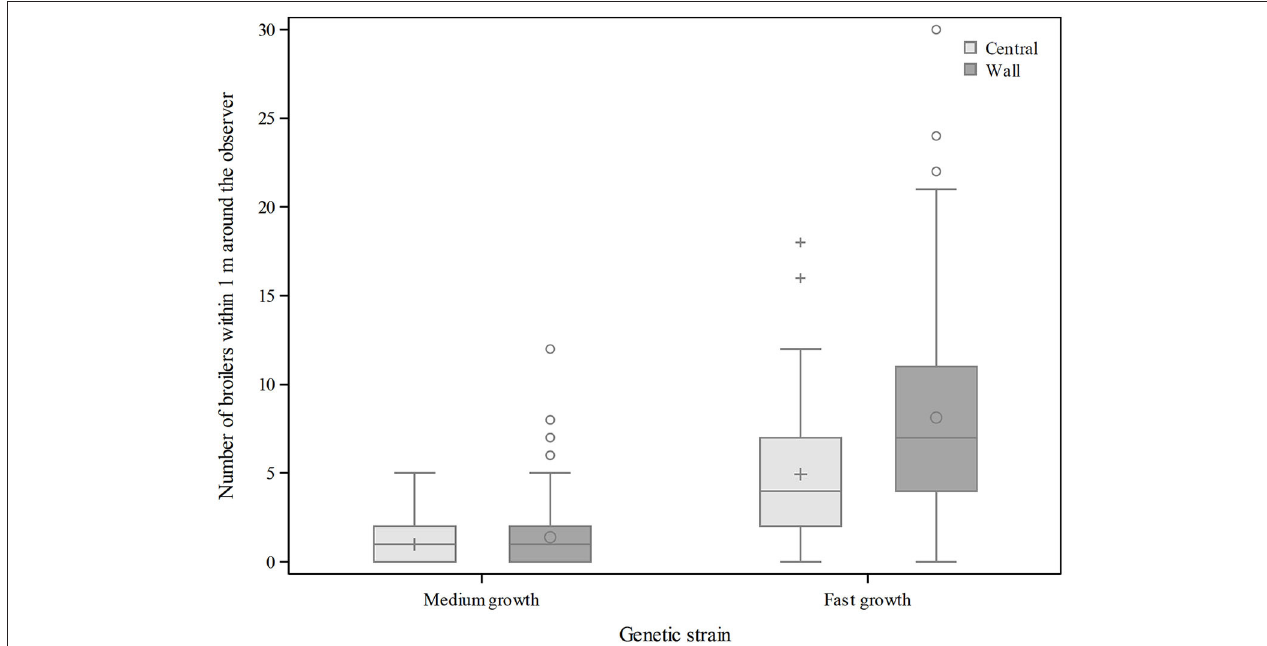
FIGURE 1 | Interaction between the genetic strain and the assessment house location on the number of broilers within 1m of the observer during avoidance tests. Boxes show interquartile ranges, and whiskers represent minimum and maximum values. Symbols ( + , ◦ ) inside boxes indicate the mean value, while symbols ( + , ◦ ) outside whiskers represent